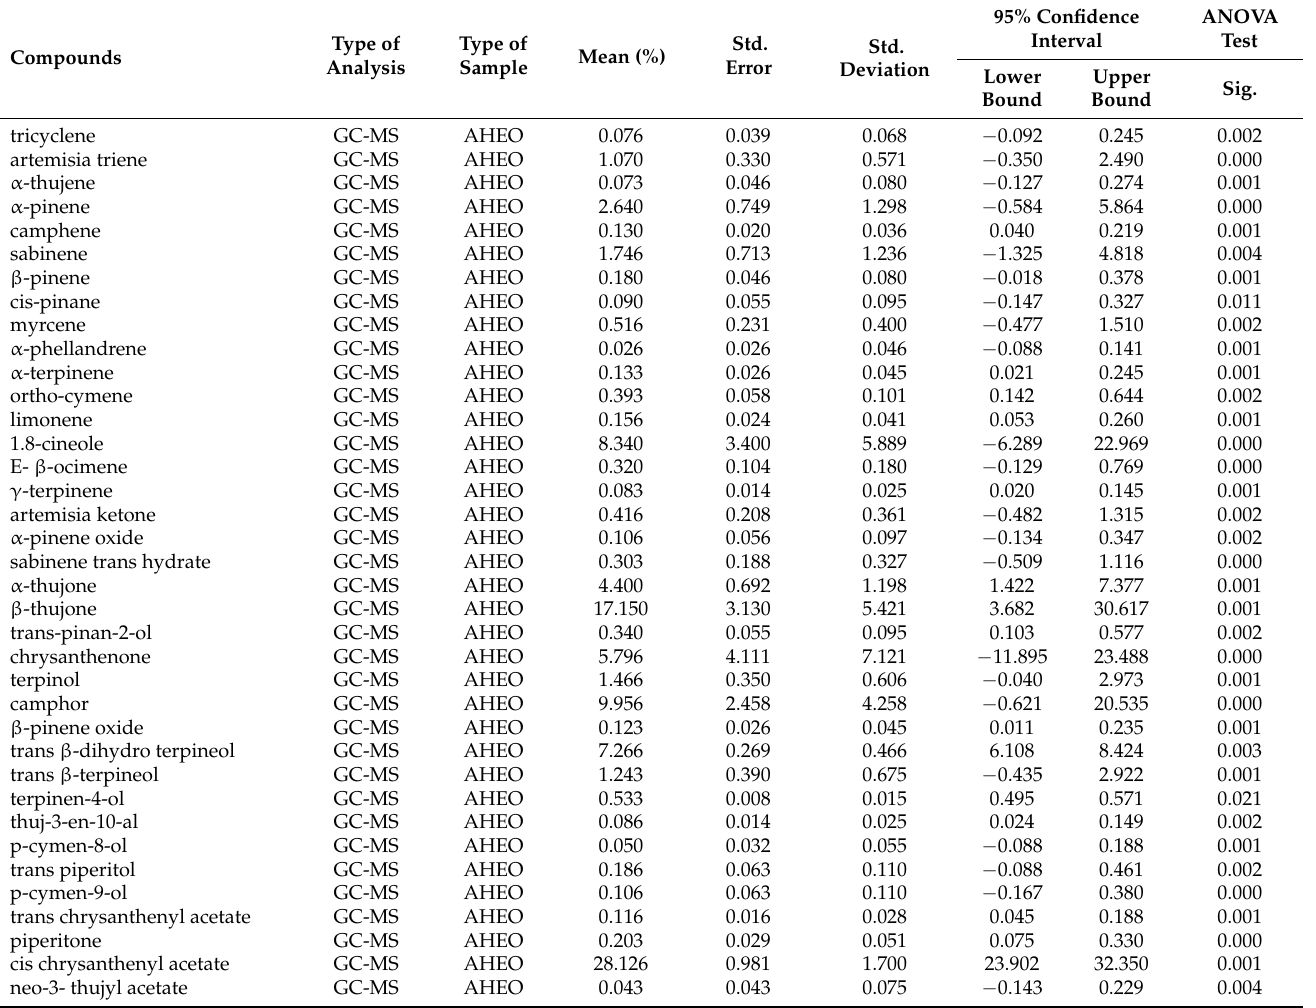
Table 2. Statistical analysis of the means performed by one-way analysis of variance